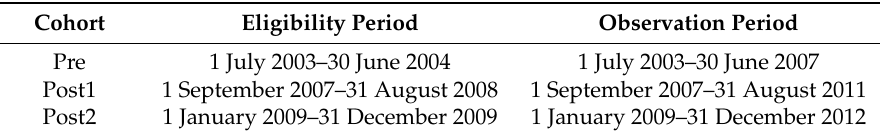
Table 1. Eligibility period and observation period for each